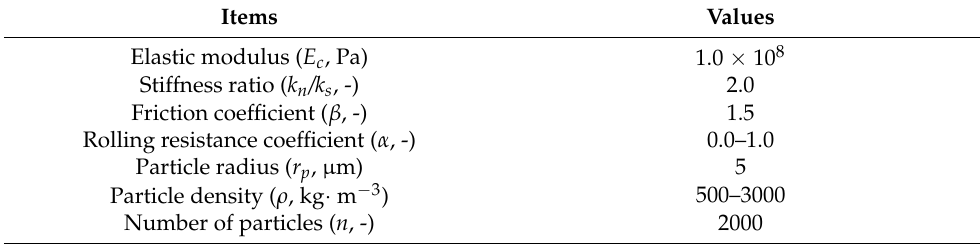
Table 1. Values of main parameters of particles in the model.